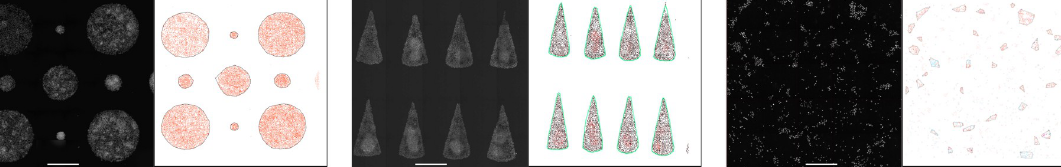
Fig 2. Classification of cells into colonies. A) mPSCs restricted to grow on micropatterned ECM spots ( left ) can be classified into colonies via the DBSCAN algorithm ( middle ). Merged and partial colonies can be excluded by applying filters to the DBSCAN clustering results ( right ). Each data point represents a cell and colonies are encircled with green lines. Scale bar = 500 μ m. B) Number of cells per colony in wells from a 96-well plate after running DBSCAN. C) Number of cells per colony in wells after excluding merged and partial colonies from the DBSCAN results. D ) Number of colonies per well after running DBSCAN with and without filters, and from a visual inspection of the images. E ) Colony identification for colonies of different sizes in the same well ( left ), colonies of non-circular geometries ( middle ), and colonies in wells without pre-patterned ECM spots ( right ). Scale bar = 500 μ